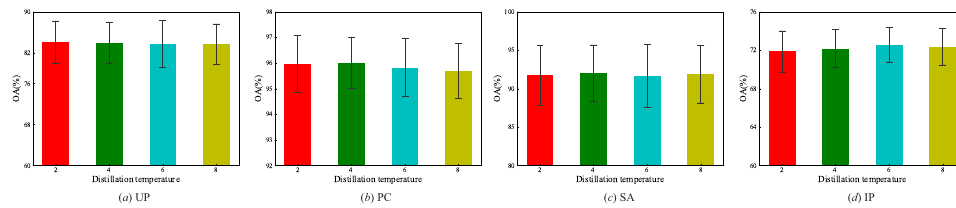
Figure 13. The results of the proposed method with different distillation temperatures.